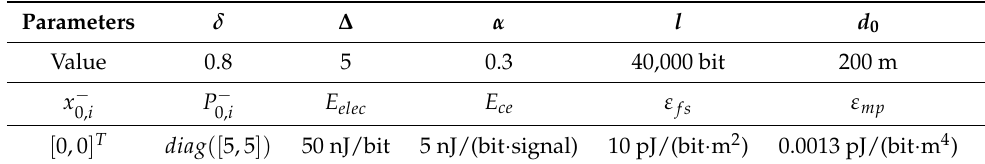
Table 3. The values of other parameters in the simulation.